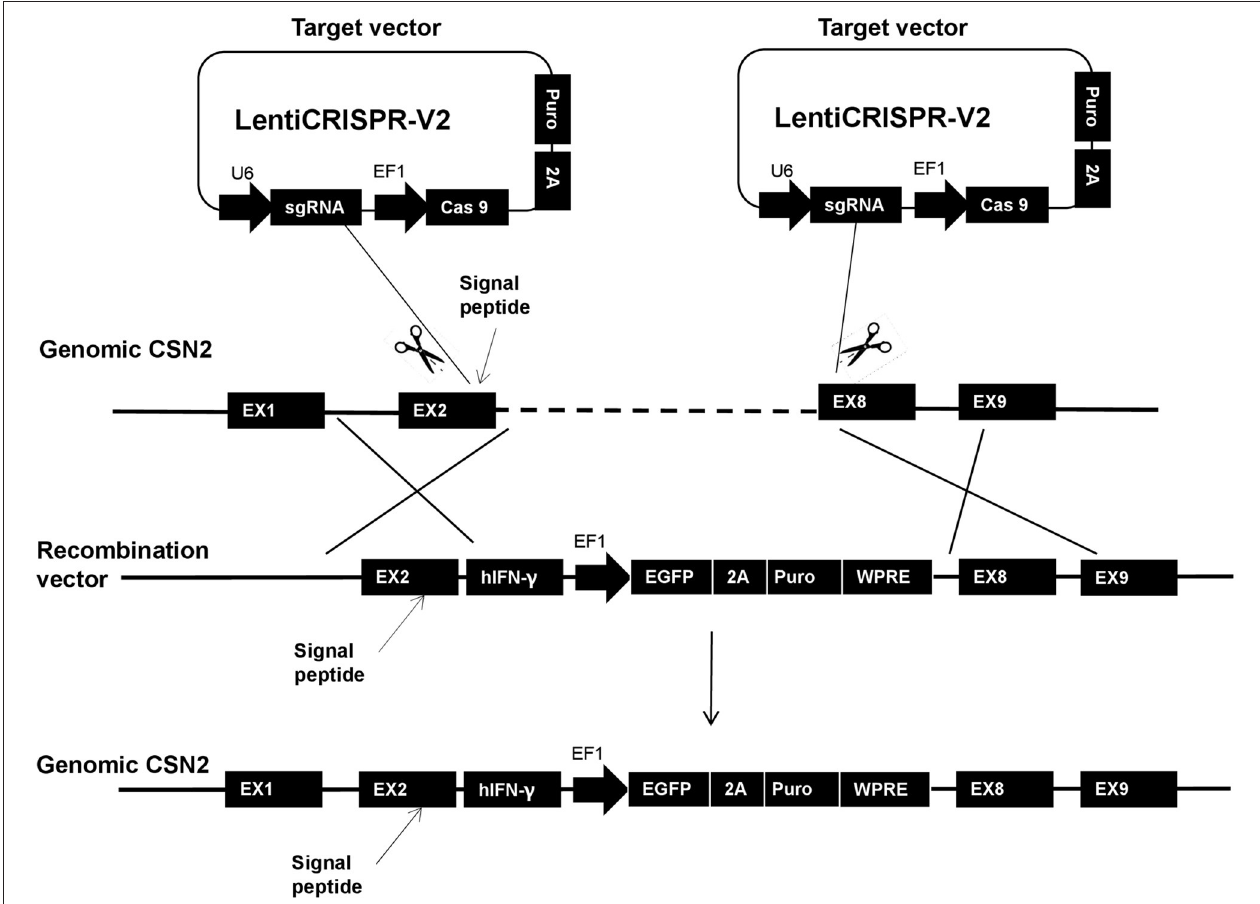
FIGURE 1 | The entire homologous integration scheme of this research. In the strategy, one target site was chosen in the 2nd exon of the casein (CSN2) gene, upstream of the signal peptide of the gene. The other site was located upstream of the 8th exon. The homologous arm (long arm: LA) of the recombination vector was designed containing the CSN2 signal peptide and used for guiding interferon-gamma (IFN- γ )